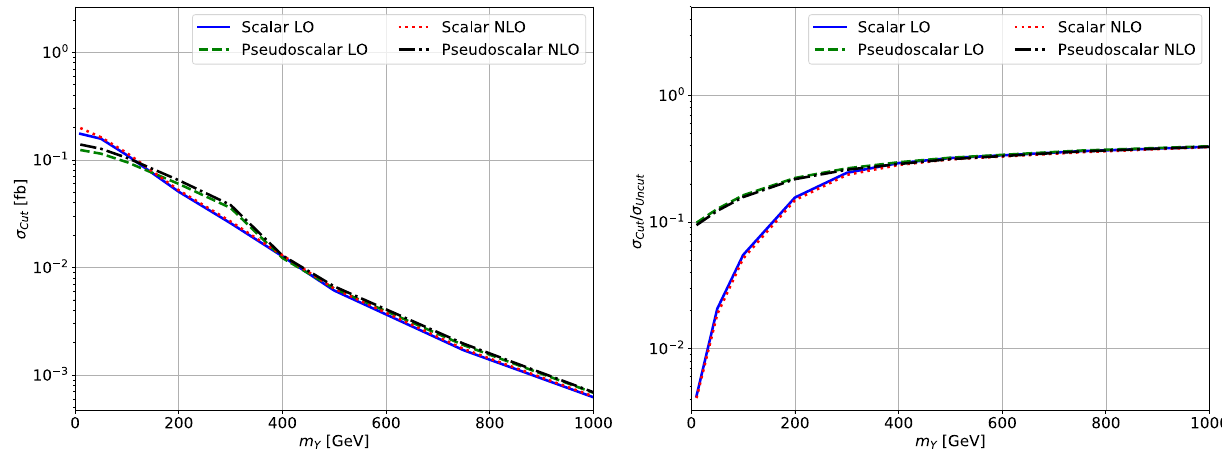
Fig. 10 Production cross section for pp → b ¯ be + μ − ν e ¯ ν μ χ ¯ χ for scalar and pseudoscalar mediators depending on the mass m Y of the mediator after applying the analysis cuts (left) and ratio between the cross sections before and after applying the additional cuts (right). The